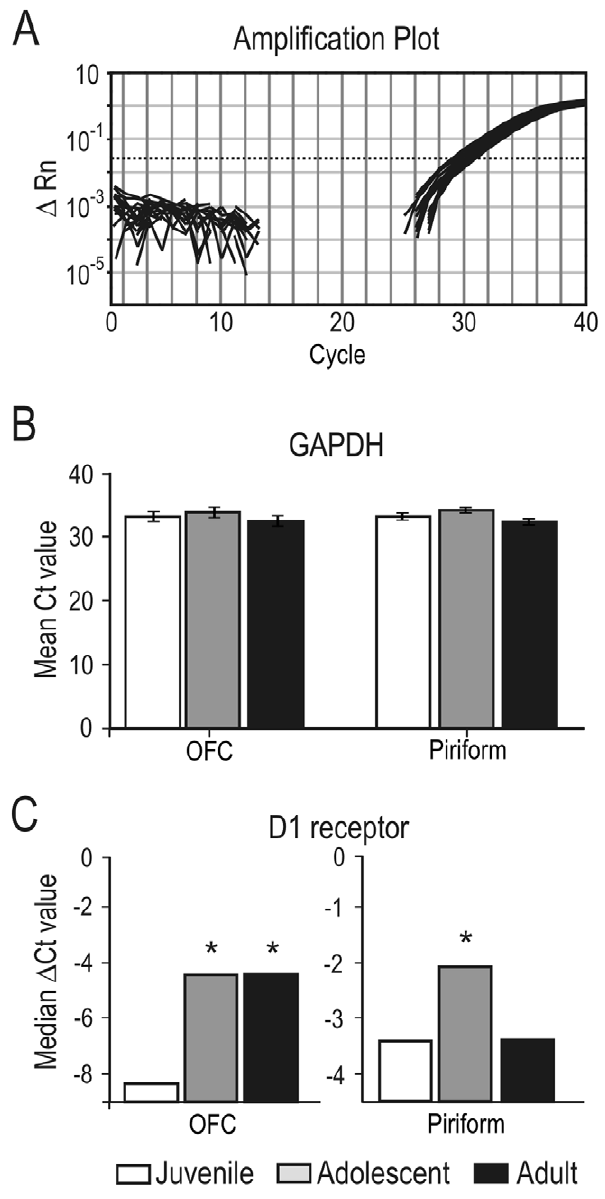
Figure 3. Dopamine D1 receptor mRNA expression increases in adolescence. A) Real-time quantitative PCR (qPCR) amplification plot showing levels of mRNA for GAPDH, a ubiquitous reference gene. Amplification plots for thirty-two samples are shown (one line for each sample), taken from both OFC and piriform cortex at different ages. The logarithmic scale D Rn is the magnitude of the fluorescence signal from the reporter dye normalized to the fluorescence of the passive reference signal, with the normalized baseline fluorescence subtracted. The dotted line displays the calculated threshold value within the exponential growth phase of the PCR that defined the threshold cycle (Ct) for each sample. The threshold value for this amplification plot was 0.027. B) Average Ct ( 6 SE) for GAPDH by age. Note that GAPDH is expressed at stable levels throughout postnatal development in both the OFC and piriform cortex. Averages are for a minimum of eight samples per age group, run in triplicate. Samples that were run as a control (either without reverse transcriptase or without the target primers and probes) showed no amplification (data not shown). Juveniles are designated by white bars, adolescents by gray bars, and adults by black bars. C) Average D Ct levels for D1 receptor mRNA relative to GAPDH levels as a function of age. Unlike GAPDH,